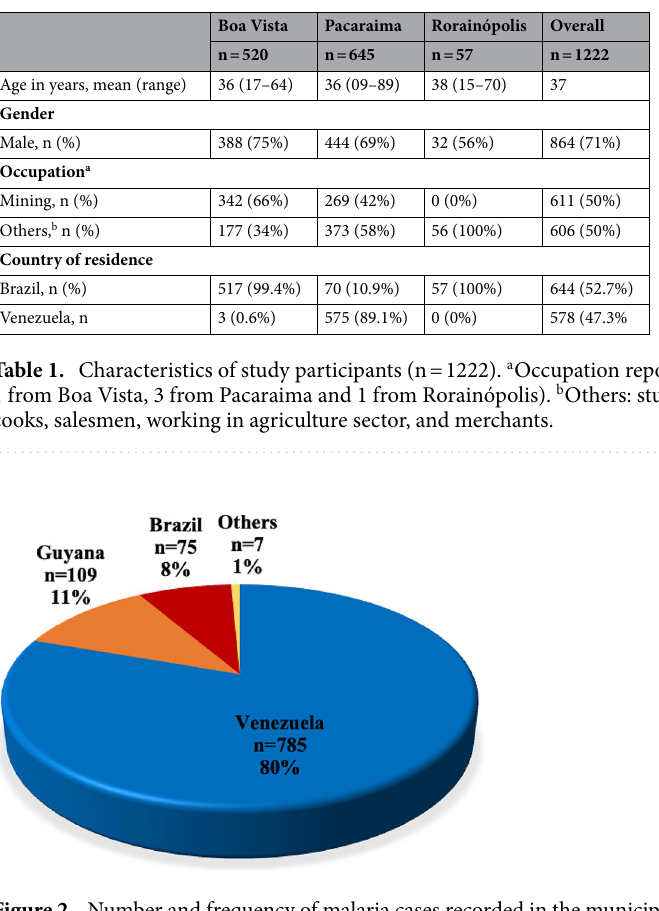
Figure 2. Number and frequency of malaria cases recorded in the municipalities of Pacaraima, Boa Vista and Rorainópolis, Roraima state, according to the probable origin of malaria infection. The probable county of origin of malaria infections based on the study participant’s reported country of residence and travel history is shown. The majority of infections were acquired in Venezuela, followed by Guyana and Brazil. Others are infections acquired in Suriname (2) and French Guiana